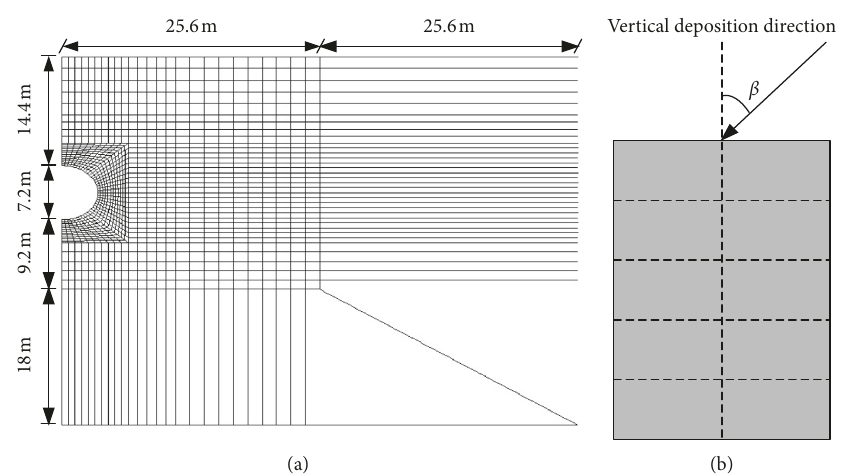
Figure 3: (a) Geometry and finite element discretization: real size with centrifuge testing. (b) The relationship between the deposition direction and the shape parameter β [27].